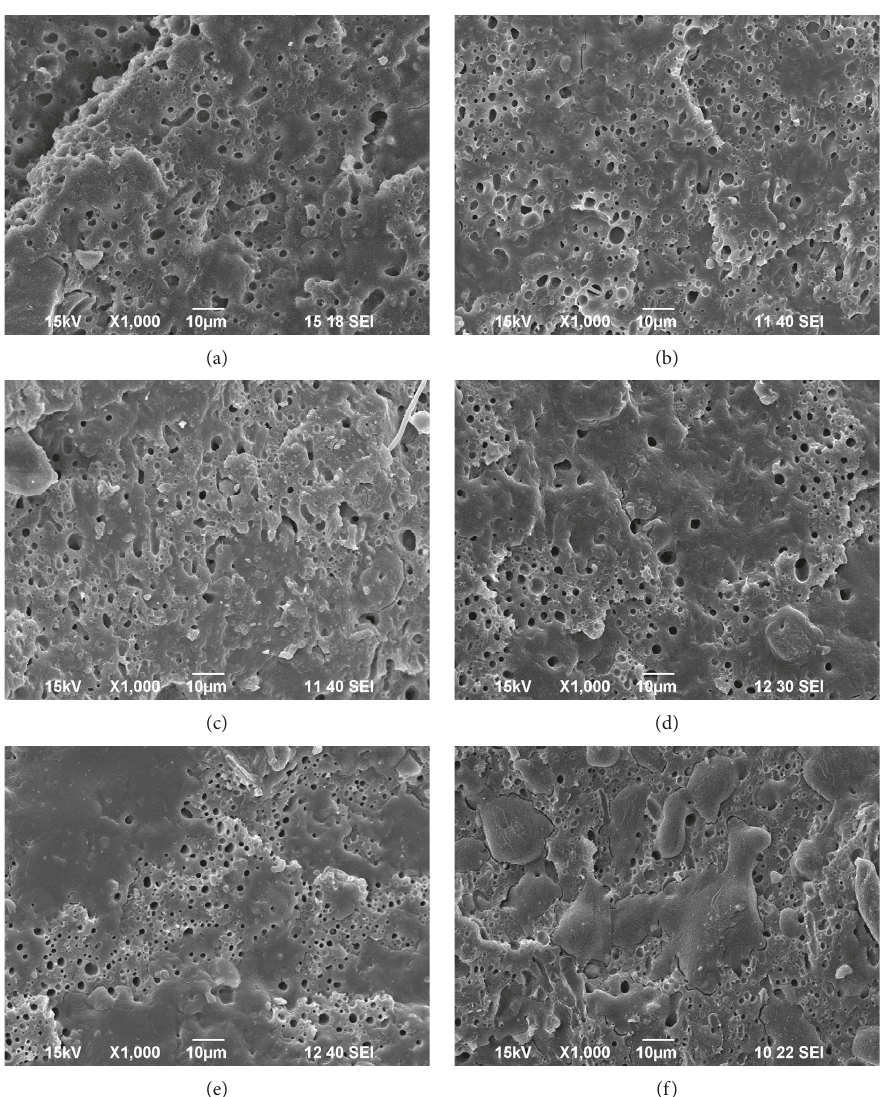
Figure 6: SEM images of the PLA/MPLA/TPS/P composite: (a) 1 wt.% of SiO (e) 3wt.% of A-SiO 2 , and (f) 5wt.% of A-SiO 2